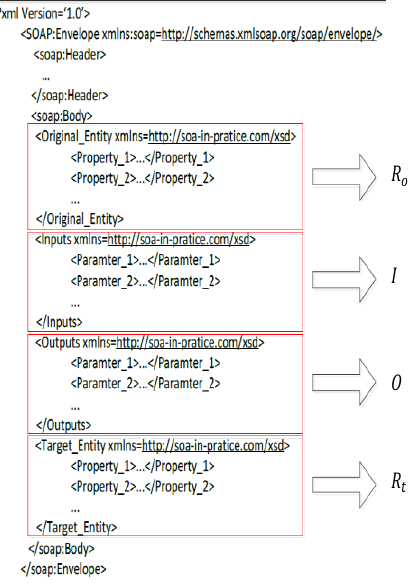
Figure 6. Example for expression of user intention based on SOAP